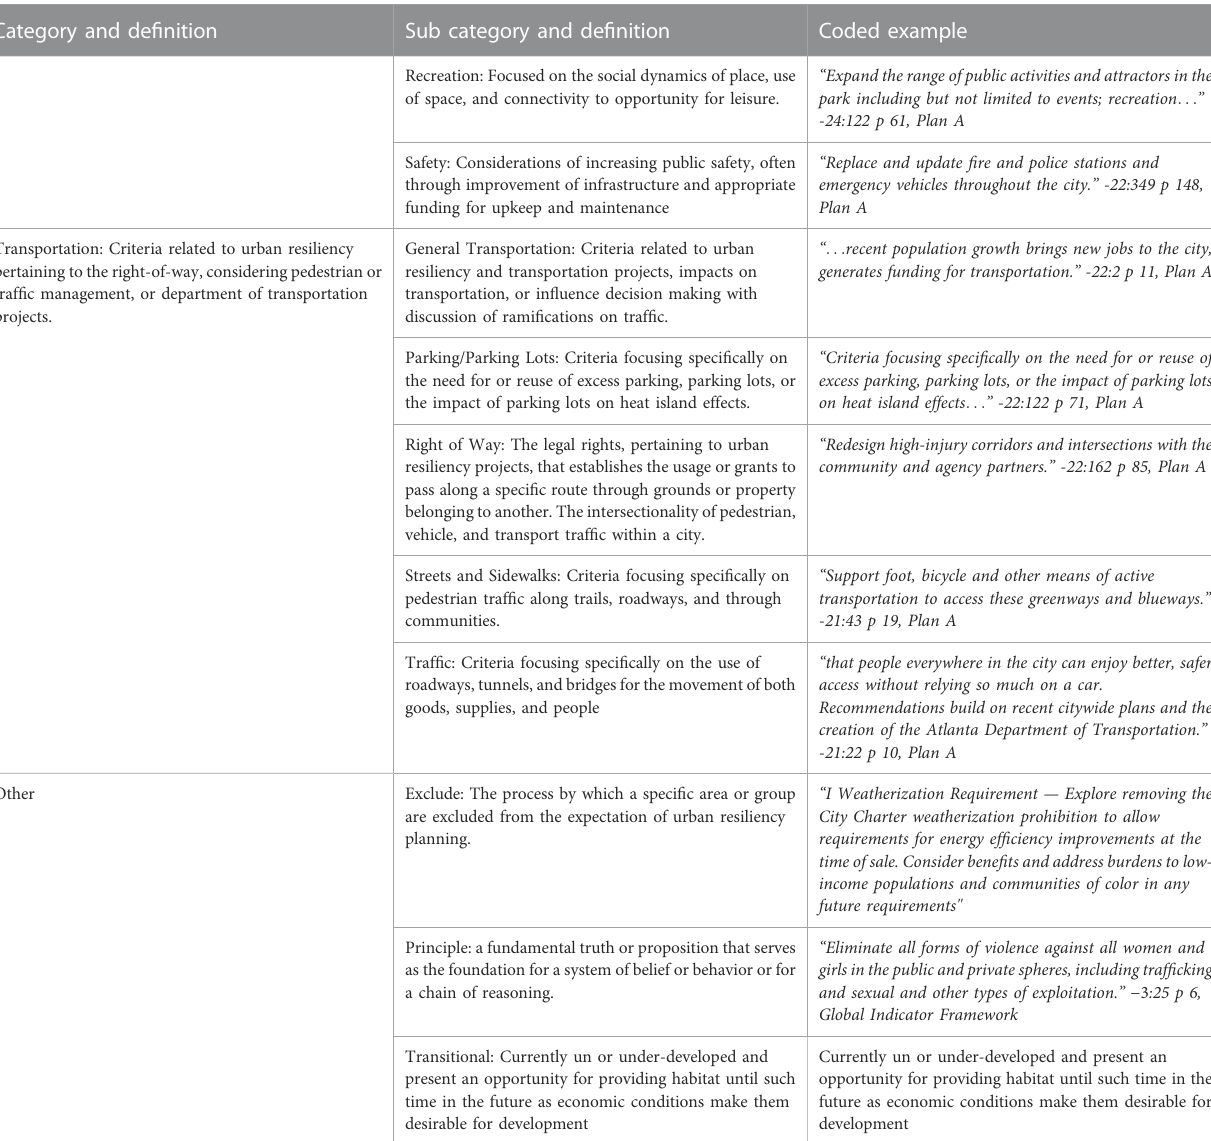
TABLE 1 ( Continued ) Comprehensive list of coding: categories, sub categories, de fi nitions, and examples of each from selected documents. Category and de fi